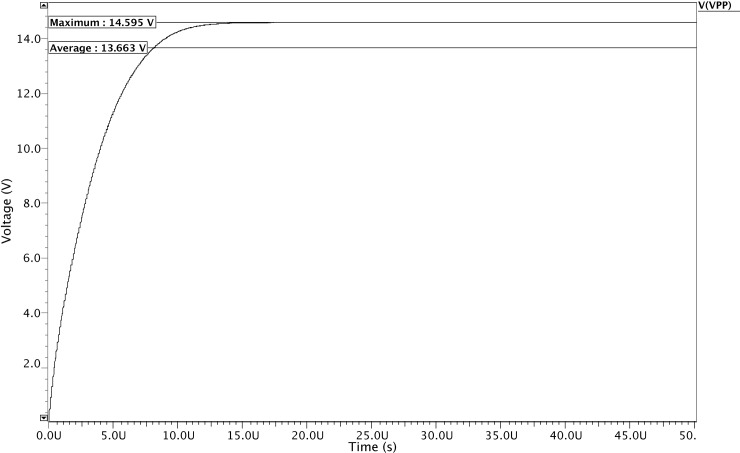
Post layout simulation output for the proposed HVG circuit.